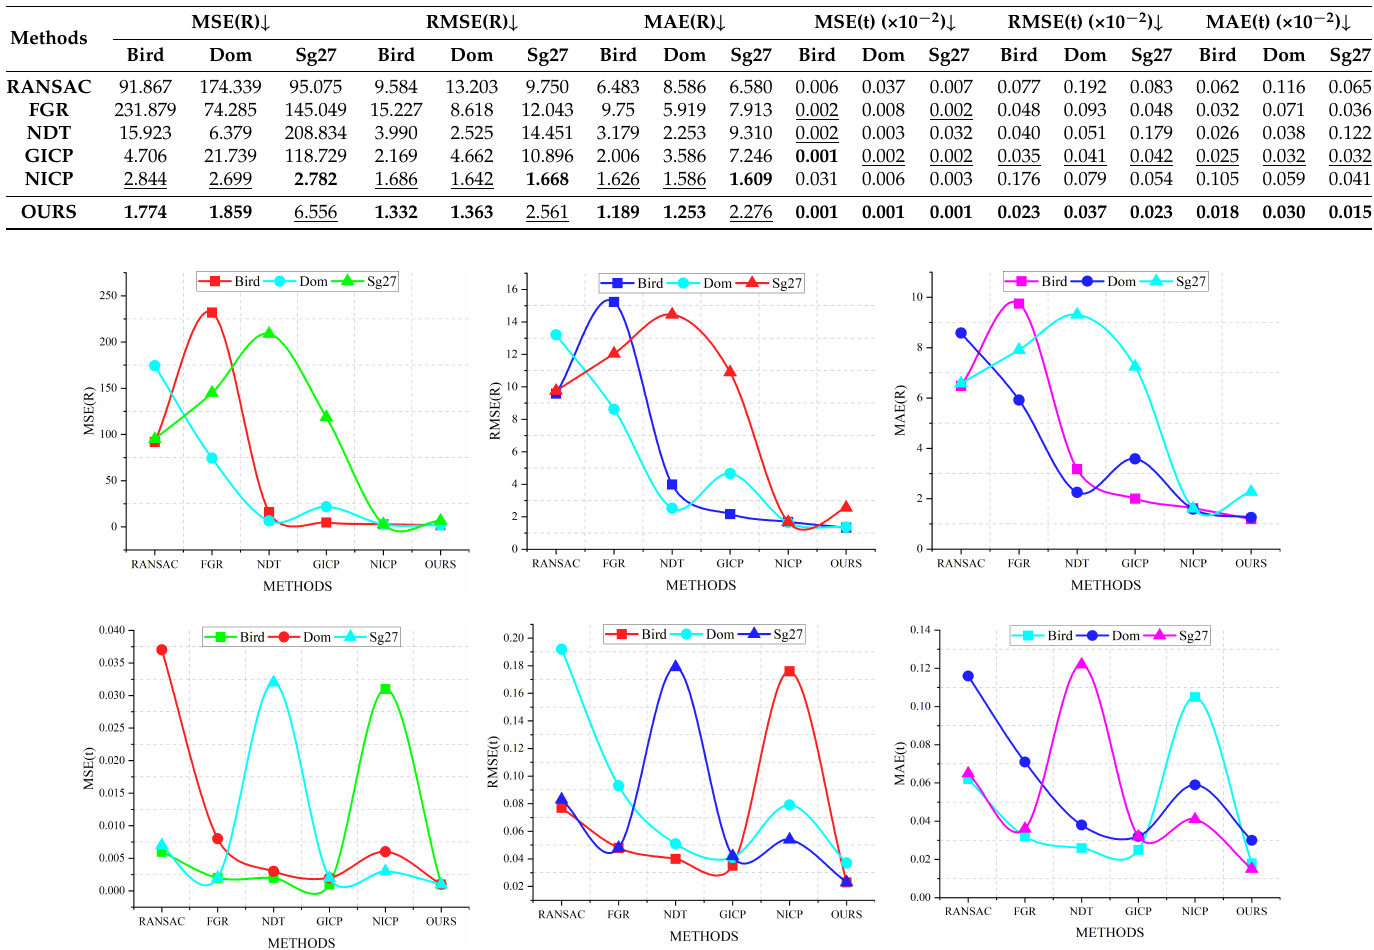
Figure 10. Registration effect comparison. Bird, Dom, and Sg27 errors were measured with different methods using MSE, RMSE, and MAE as measurement